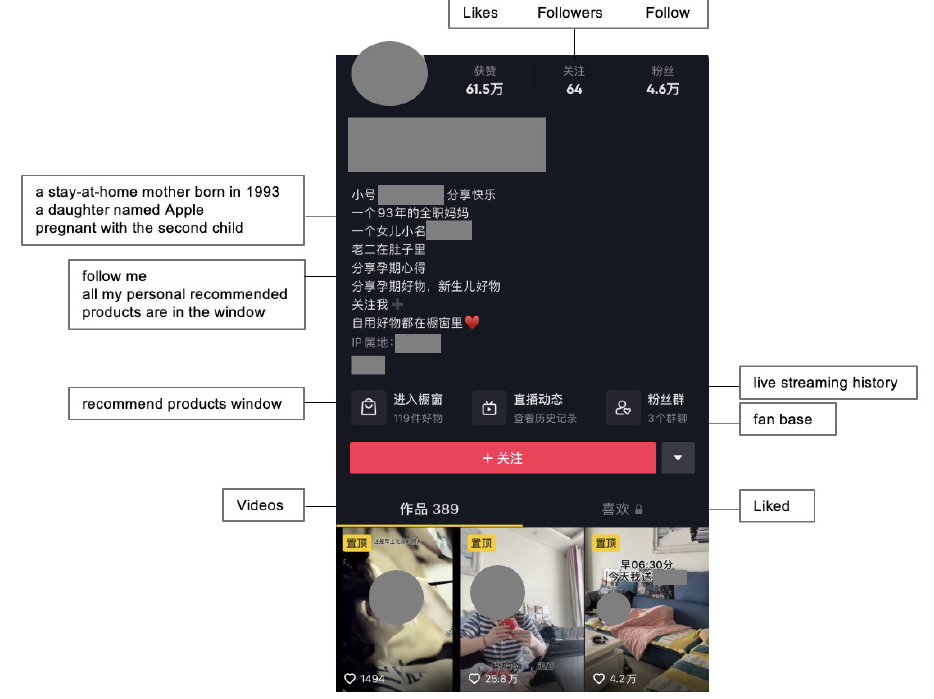
Figure 1. Meng Meng’s